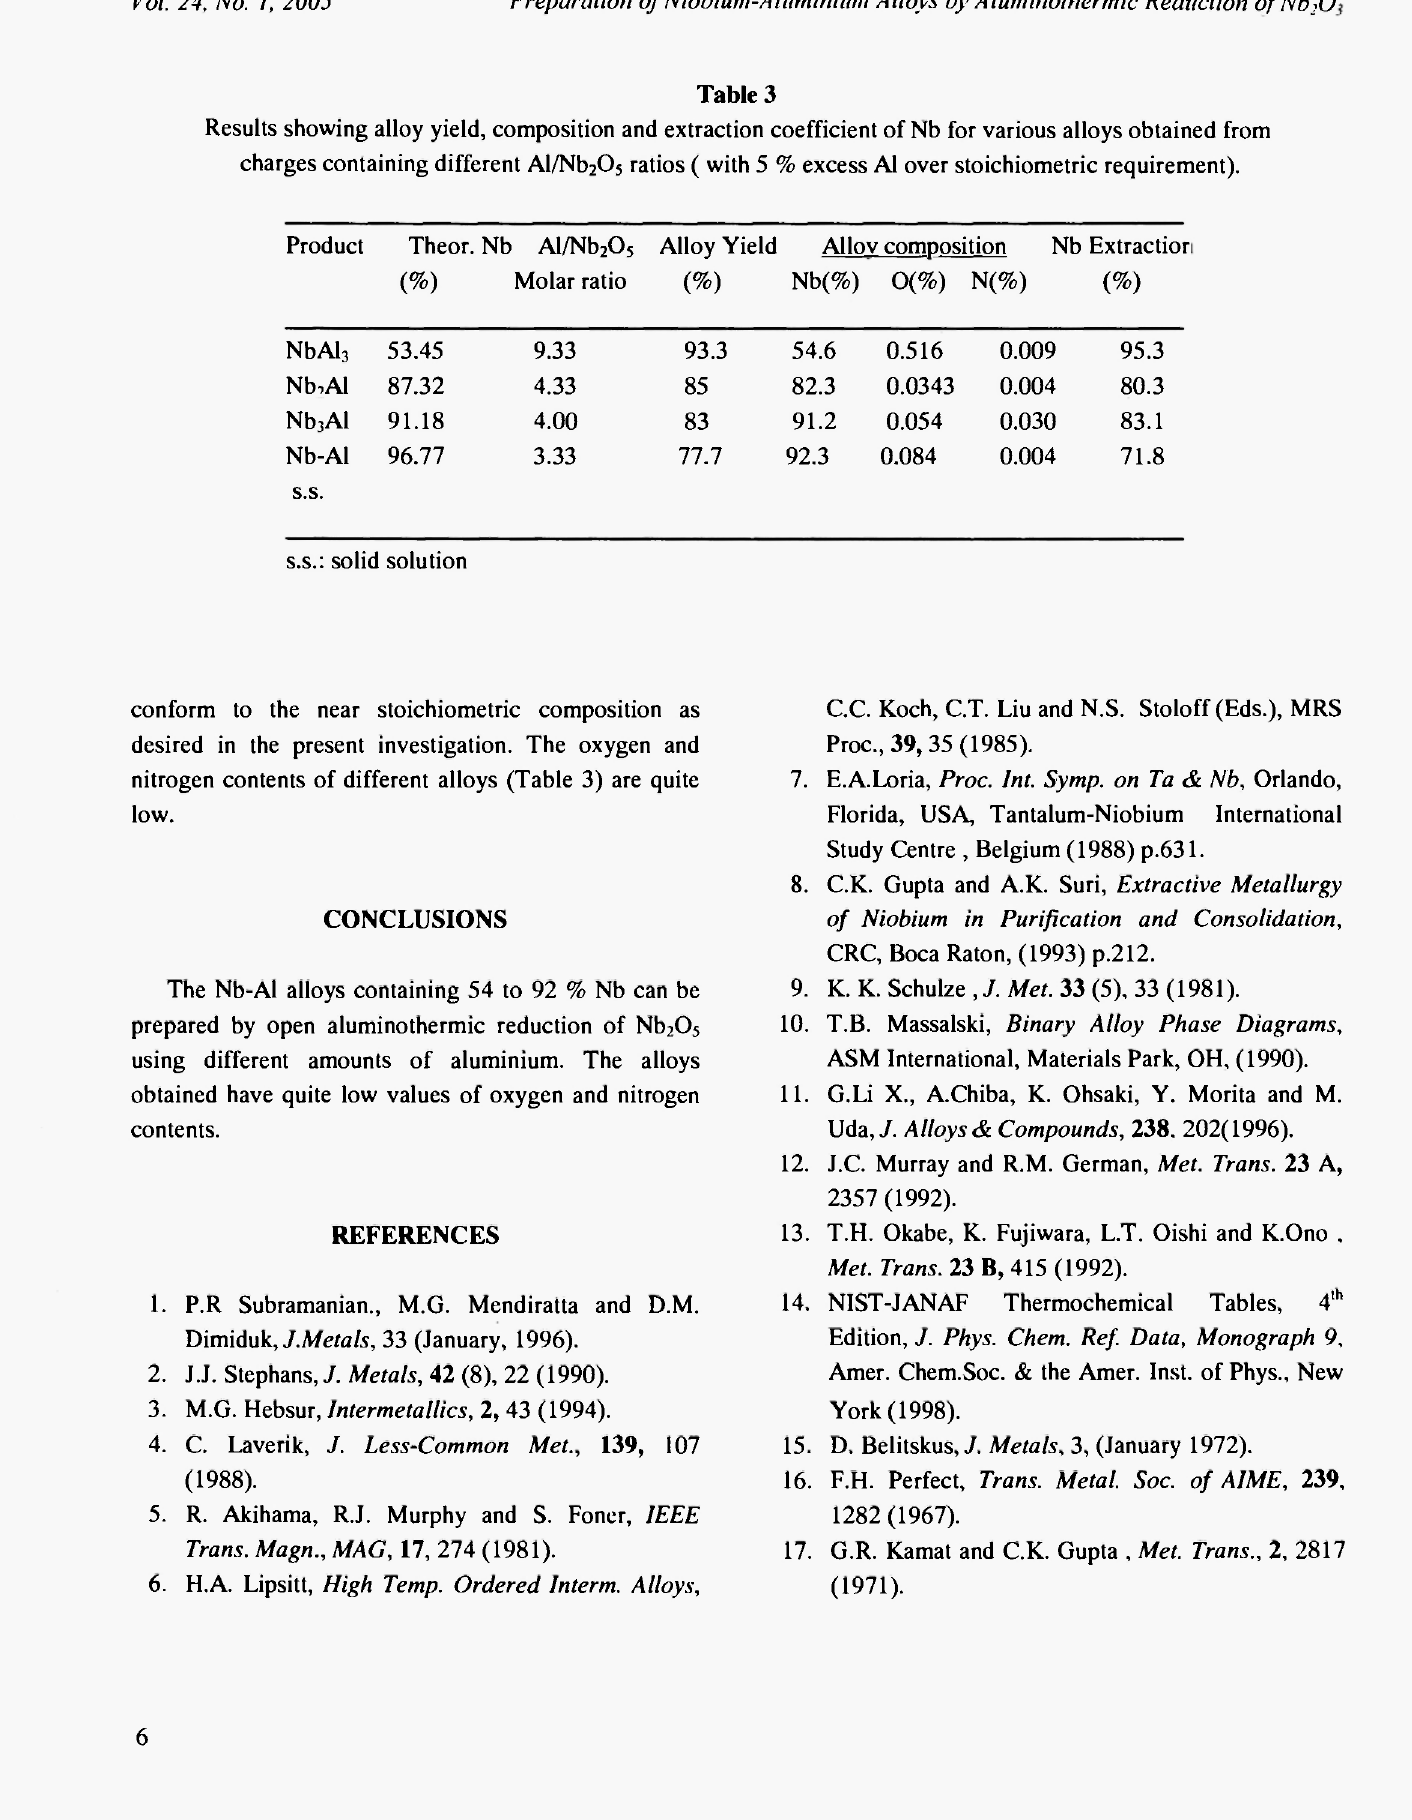
Results showing alloy yield, composition and extraction coefficient of Nb for various alloys obtained from charges containing different Al/Nb 2 0 5 ratios ( with 5 % excess Al over stoichiometric